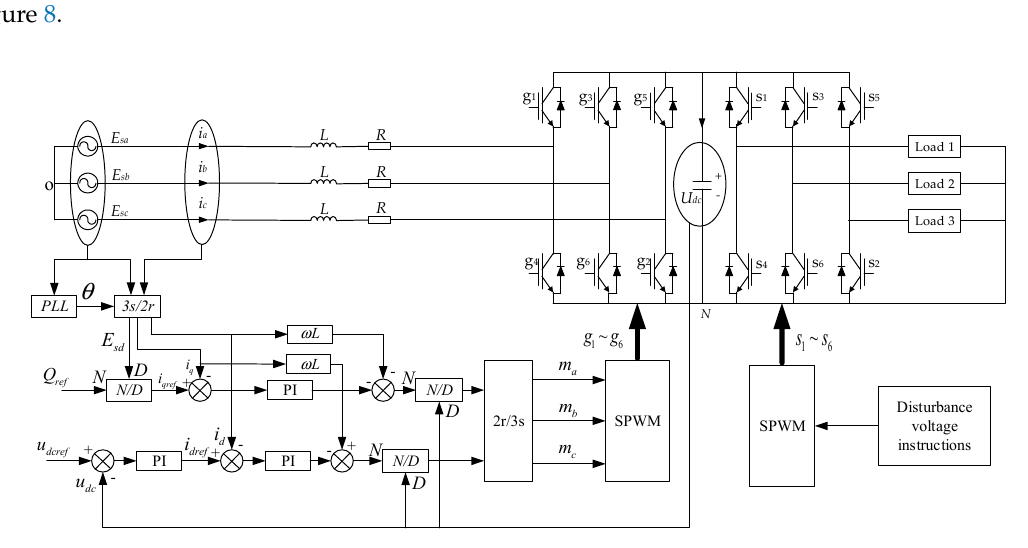
Figure 8. Structure diagram of the control system.